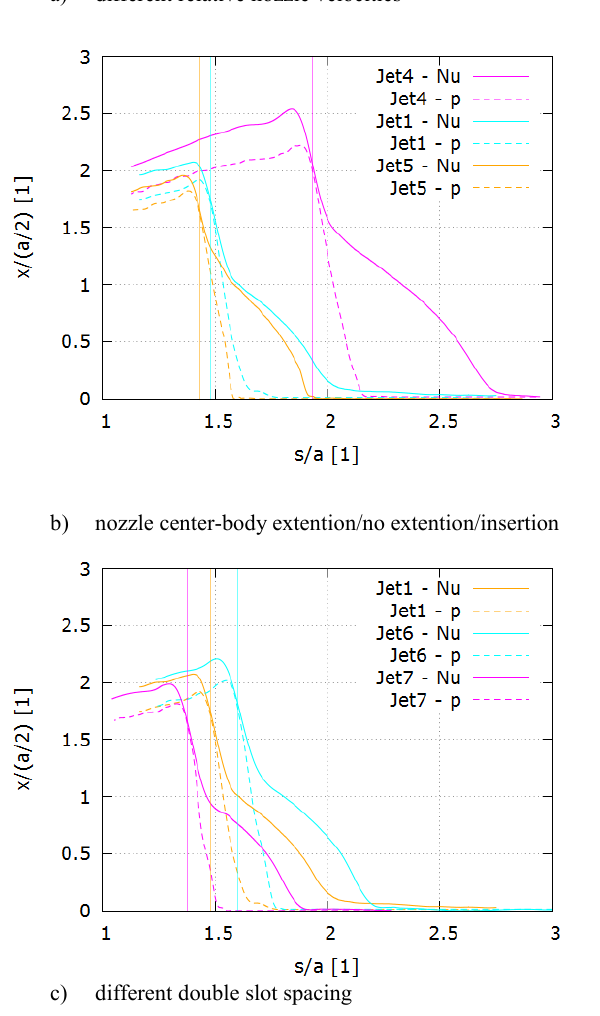
Fig. 6. Distances of local maxima from the jet axis Figure 6 deals only with the pattern A to pattern B transitions and shows positions of stagnation pressure (dashed line) and heat transfer coefficient (solid line) maxima against the normalized nozzle-to-wall distance. Vertical lines show that the overall maxima in heat transfer coefficient coincide with the overall maxima for stagnation pressure. Interesting is that generally, in